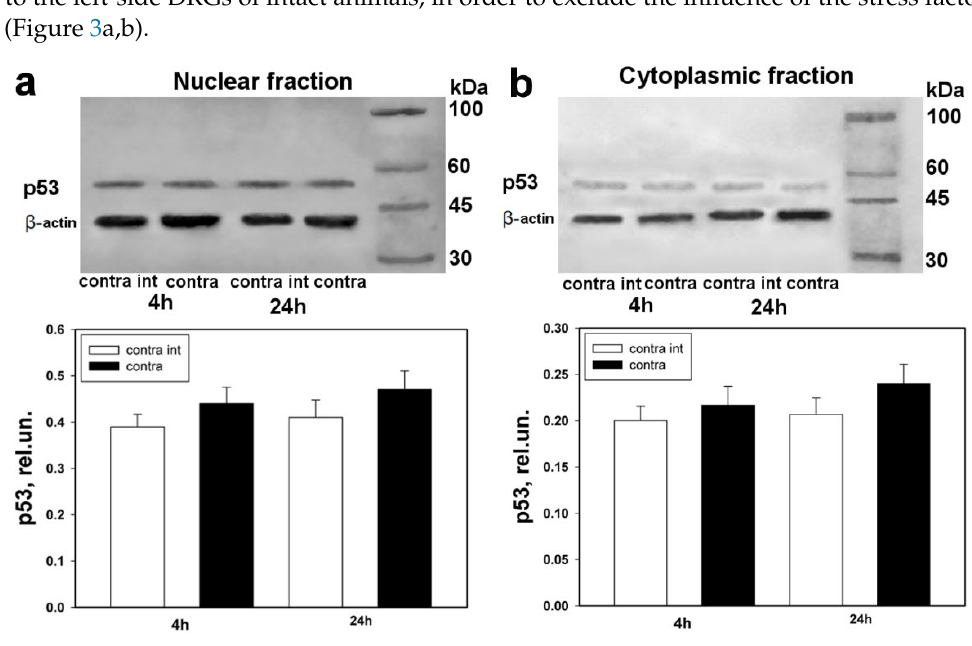
Figure 3. Western blot analysis. Expression of p53 in contralateral DRGs of the control group of animals, which underwent right-side sciatic-nerve transection followed by administration of physiological solution, in comparison with left-side DRGs of intact animals, to which only physiological solution was administered after 4 h and 24 h. ( a ) Nuclear fraction; ( b ) cytoplasmic fraction. One-way ANOVA. Мean ± SEM. n = 6.